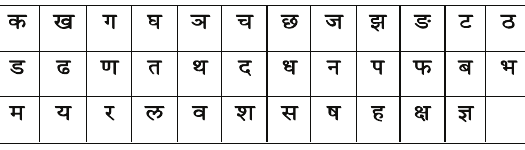
Figure 6: Devnagari Consonants.